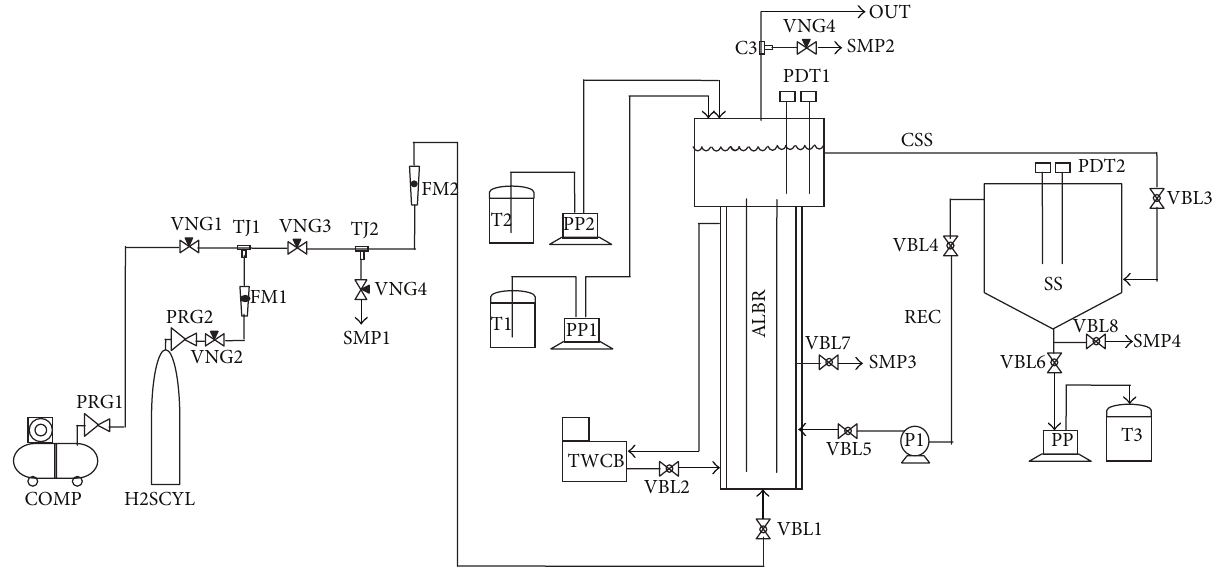
Figure 1: Schematic of the bioreactor system. ALBR: air-lift bioreactor; COMP: air compressor; CSS: cell and sulfur suspension; FM: flow meter; H 2 SCYL: H 2 S cylinder; OUT: outlet air to hood; P: circulation pump; PDT: pH/DO/Temp sensors; PP: peristaltic pump; PRG: pressure reducer and pressure gauge; REC: recycled cell suspension; SMP: gas/liquid sampling; SS: sulfur settler; T: tanks (1: nutrient; 2: HCl; and 3: sulfur sludge); TJ: tee joint; TWCB: thermostated water circulation bath; VNG: gas needle valve; and VBL: liquid ball